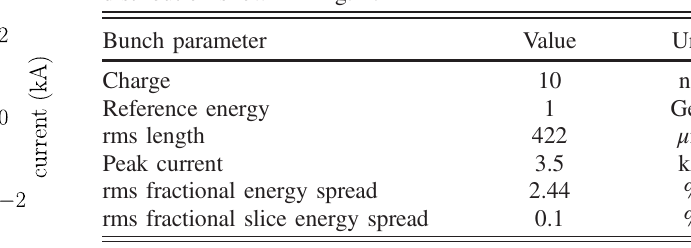
FIG. 3. Block diagram of the drive bunch